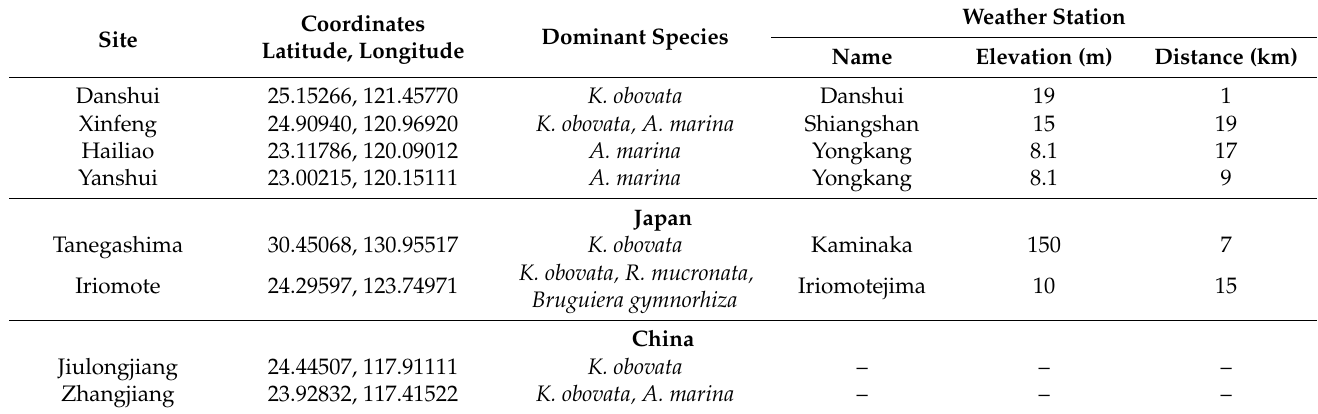
Table 1. Characteristics of the eight sites and their associated meteorological stations. Species compositional and manage- ment data from